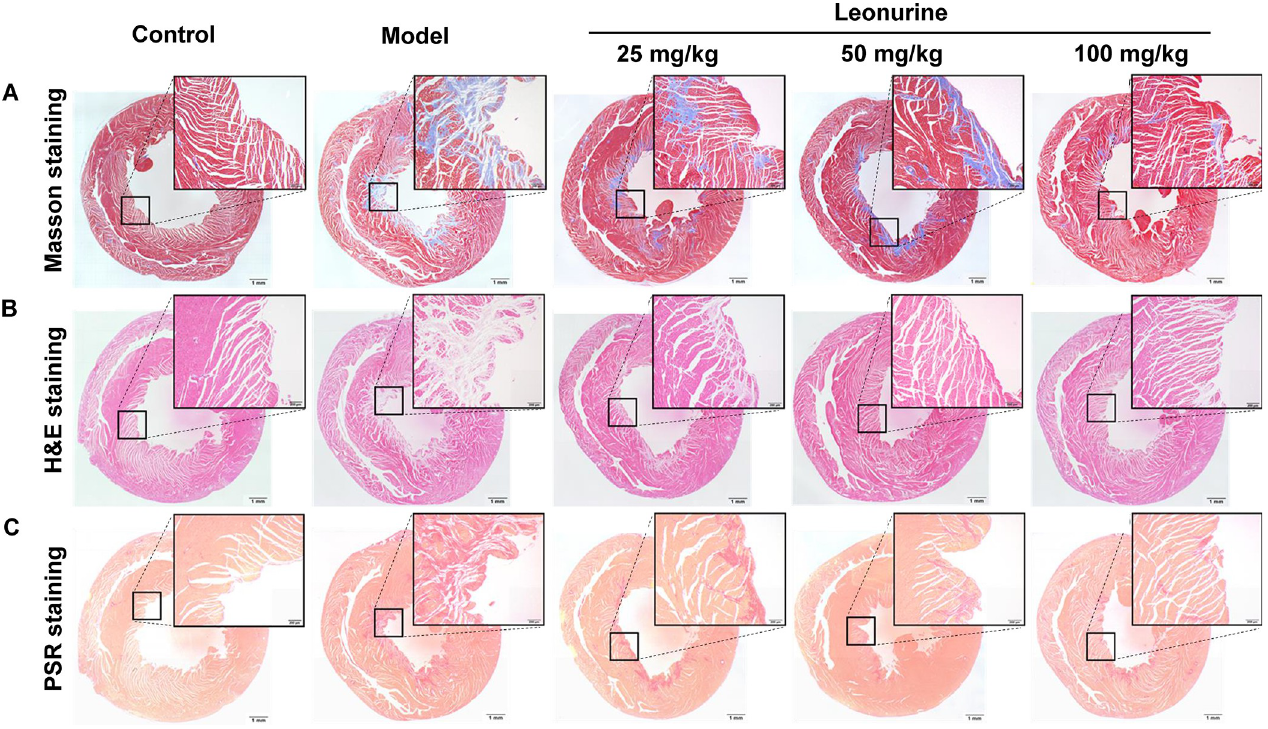
Fig 3. Leonurine reduced the area of cardiac fibrosis in rats with ISO-induced heart failure. (A) Masson staining on the heart, blue = fibrous collagen. (B) H&E staining on the heart, pink = fibrous collagen. (C) PSR staining on the heart, red = fibrous collagen (bar, 1 mm; magnification, × 4, × 40). H&E, haematoxylin and eosin; PSR, Sirius red.